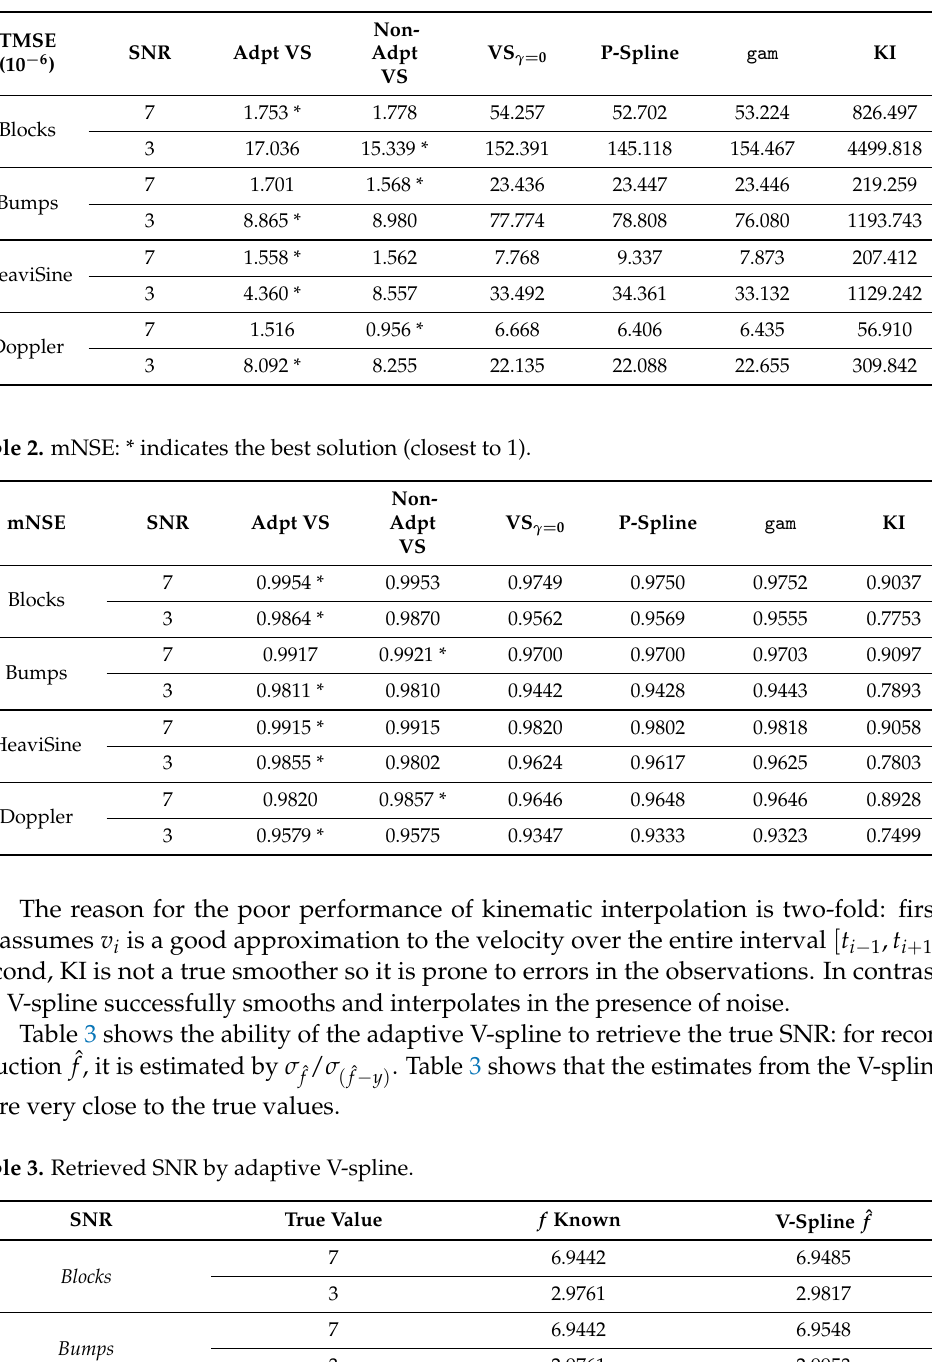
Table 1. TMSE: * indicates the best solution (smallest error).